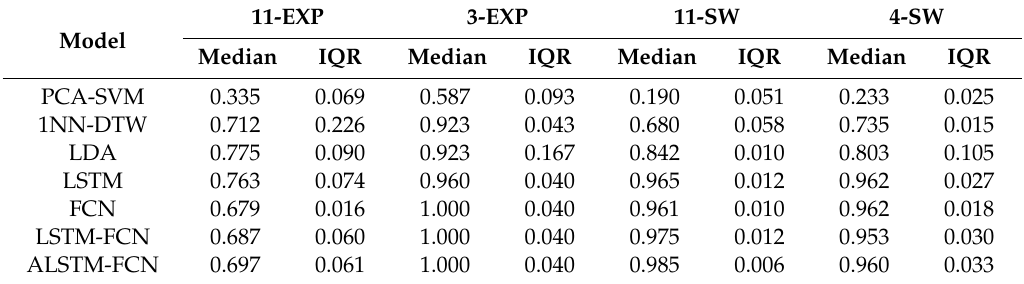
Table 1. F1-score (median of macro-averages and interquartile-range (IQR)) following cross-validation.